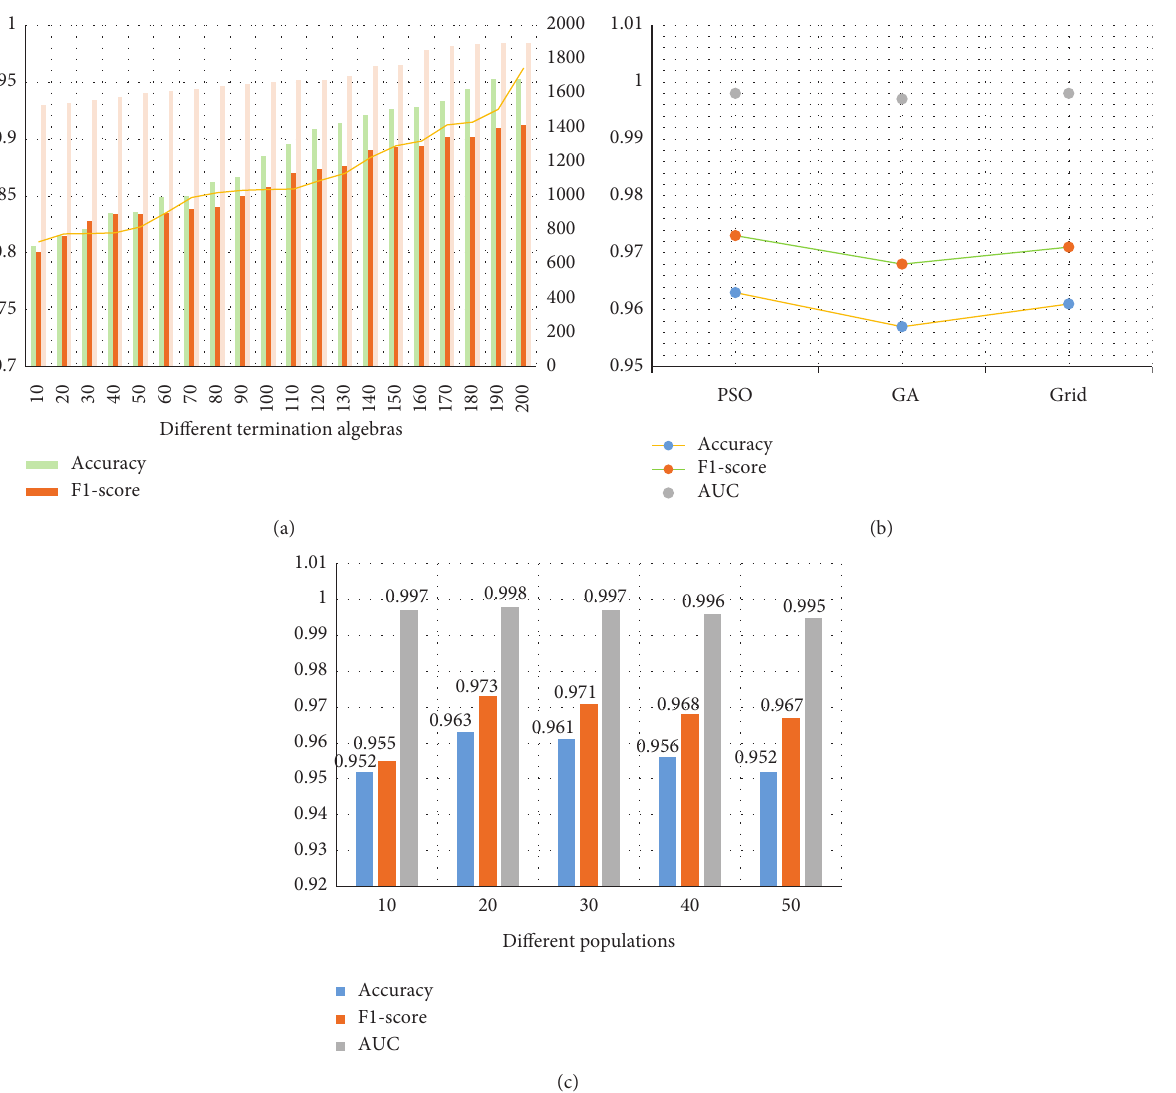
Figure 8: Comparison of results in different